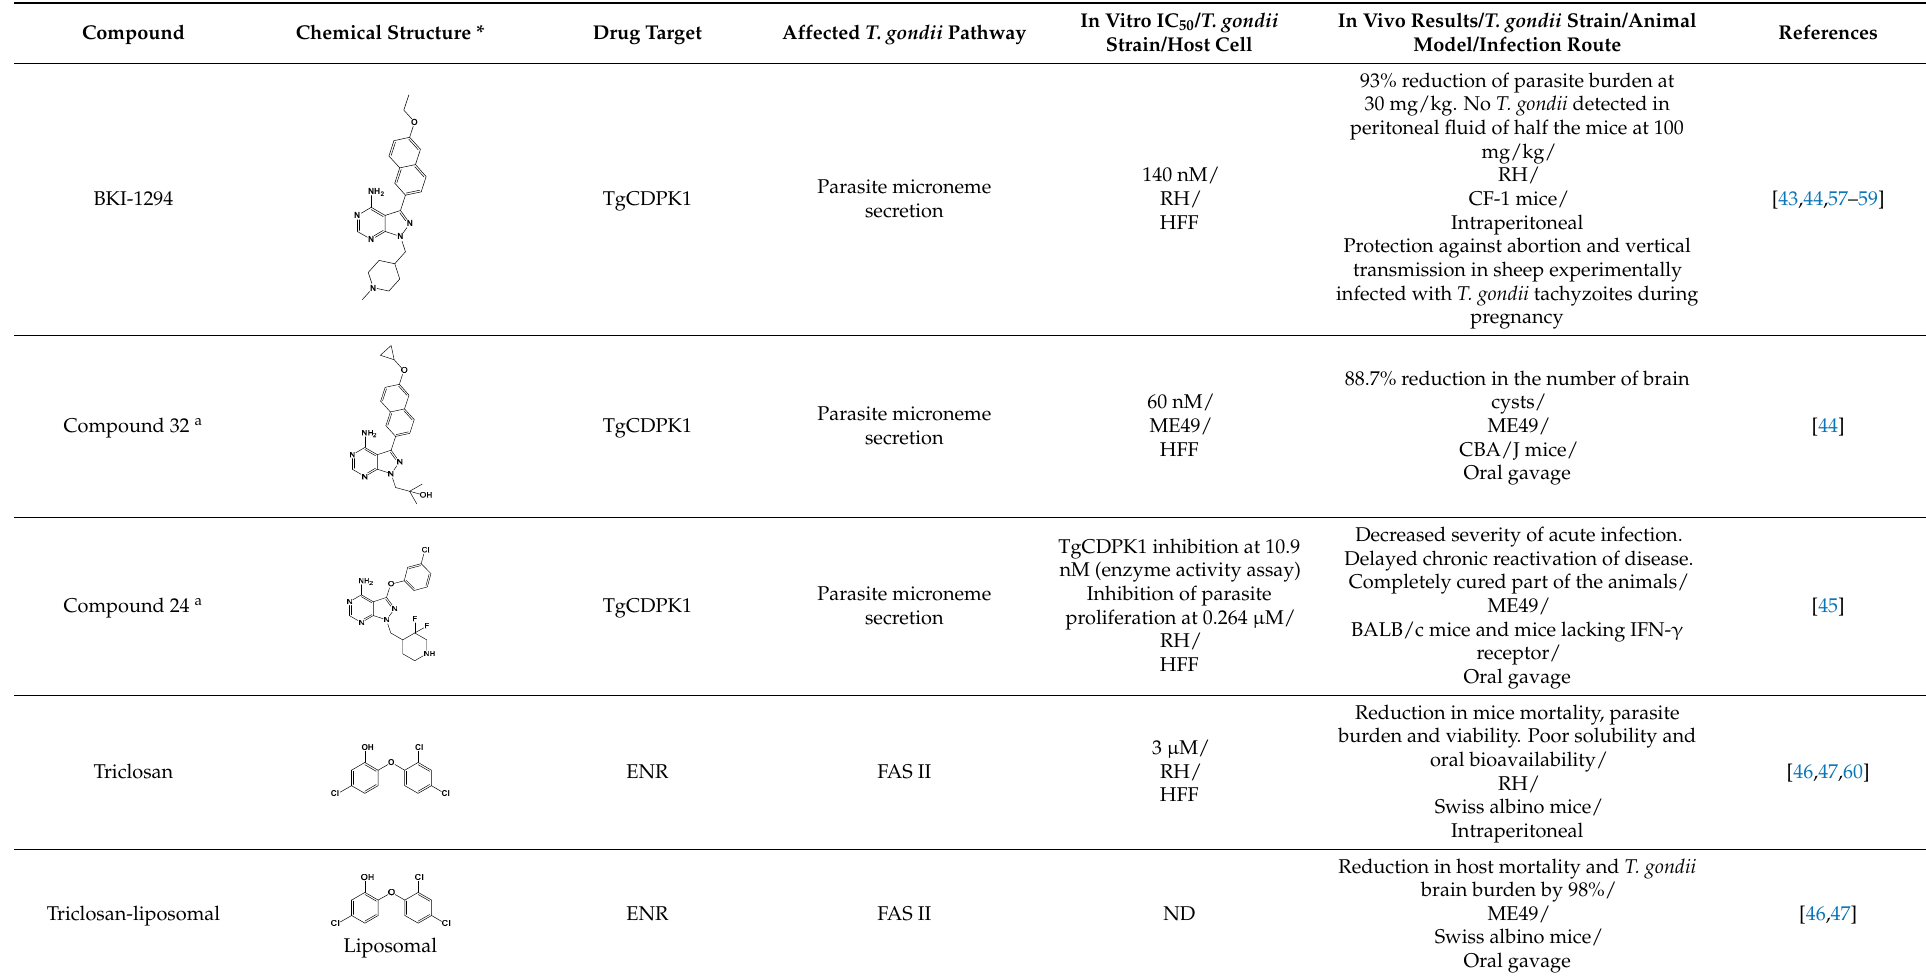
Table 2. Experimental compounds with anti- Toxoplasma gondii activity.